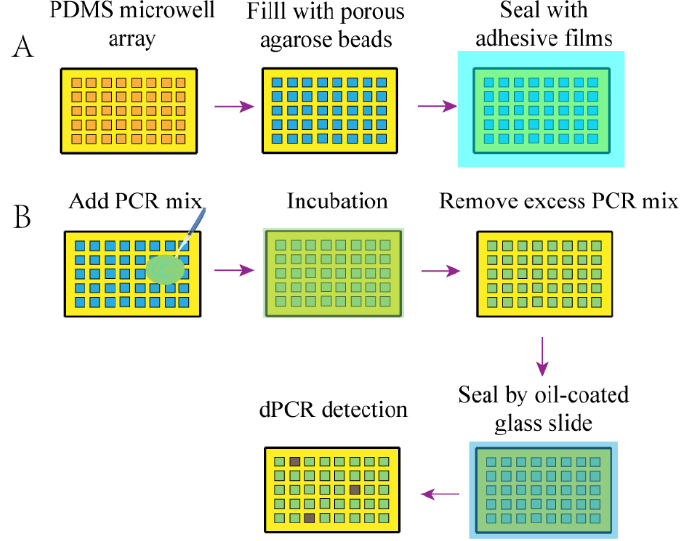
Figure 5. dPCR using a superporous absorbent array chip [77] . ( A ) Schematic of fabrication of